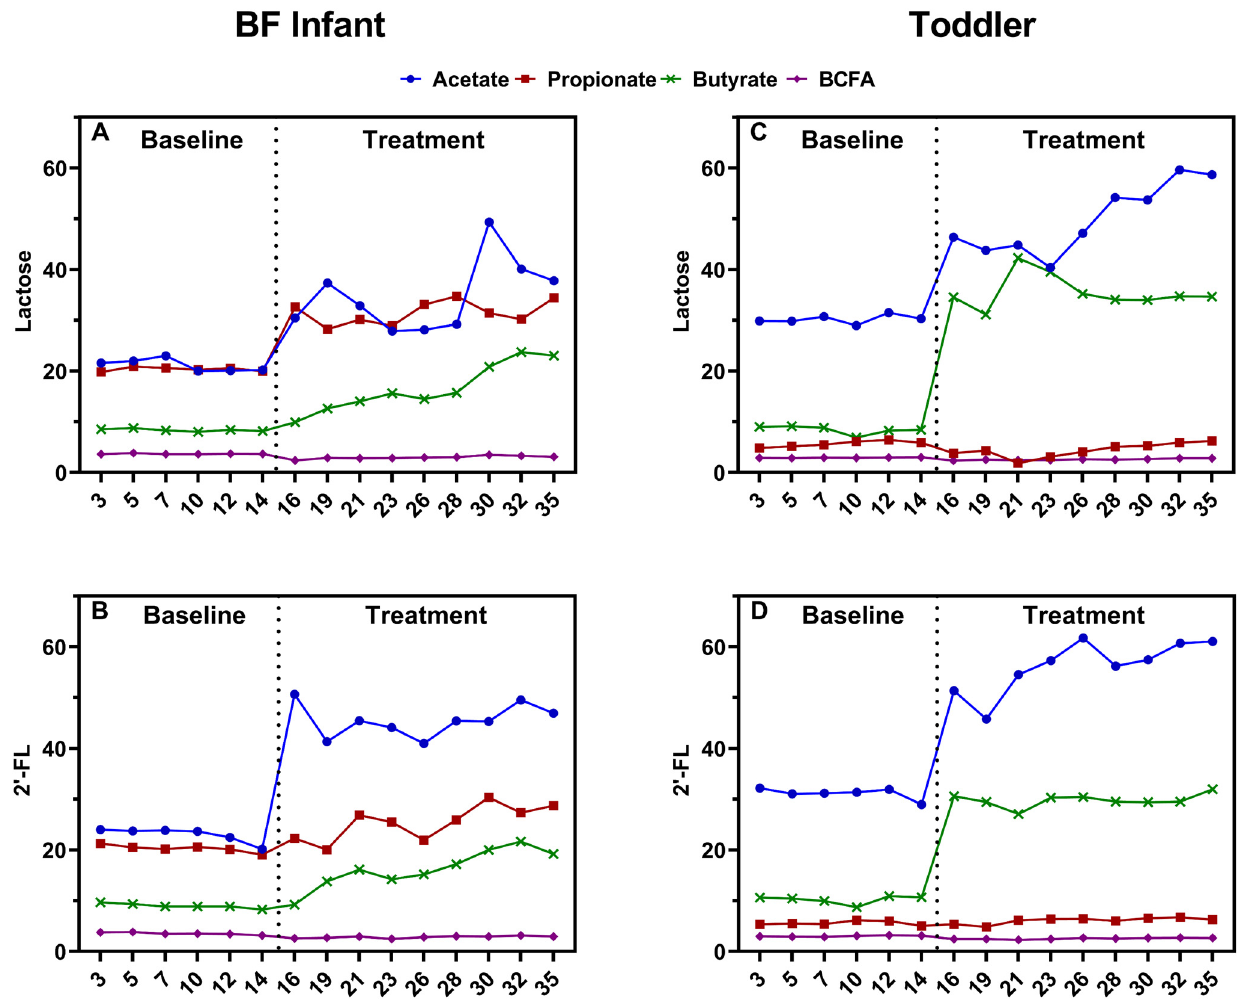
Figure 6. Effect of lactose or 2’-FL on microbial metabolites in the proximal colon of the long-term M-SHIME in vitro system. Time course graphs represent acetate, propionate, butyrate and BCFA levels (mM) in the proximal colon during the baseline (d0–d14) and treatment (d14–d35) periods in the M-SHIME ® model: ( A ) lactose treatment to BF infant microbiota; ( B ) 2’-FL treatment to BF infant microbiota; ( C ) lactose treatment to toddler microbiota and ( D ) 2’-FL treatment to toddler microbiota. 2’-FL = 2’fucosyllactose; BCFA = branched-chain fatty acids; BF = breastfed; d = day; M-SHIME ® = mucosal simulator of the human intestinal microbial ecosystem.